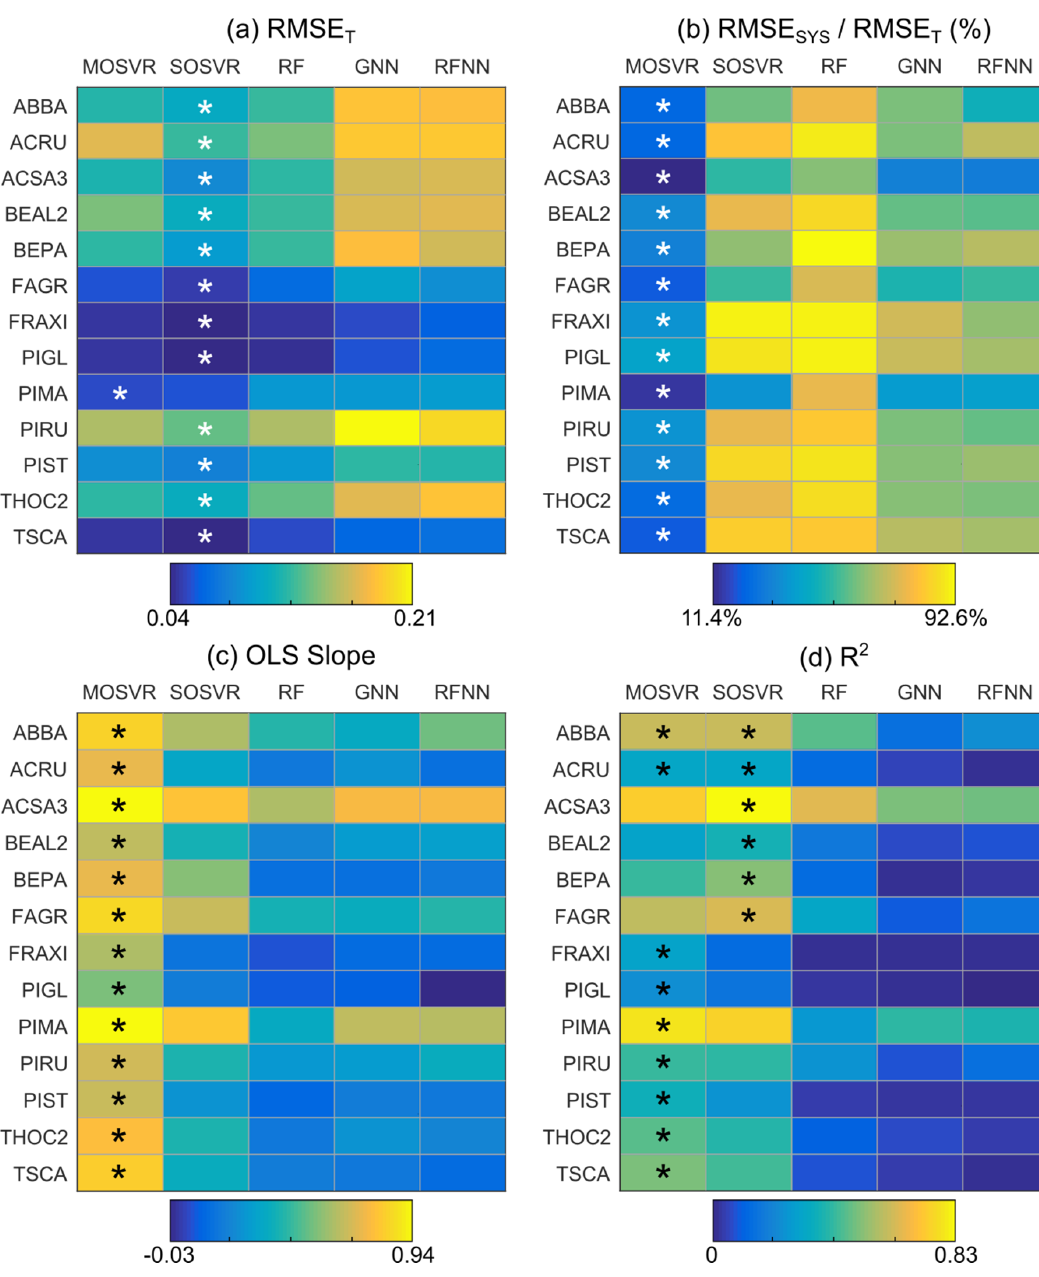
Figure 5. Predictive performance by species and model type. Performance metrics were obtained from linear regression of CV predictions against observed values, averaged across 100 repetitions of a 10-fold CV. Asterisks indicate model types that produced either the best mean metric value for a given species or a value whose 95% confidence interval overlapped that of the best.